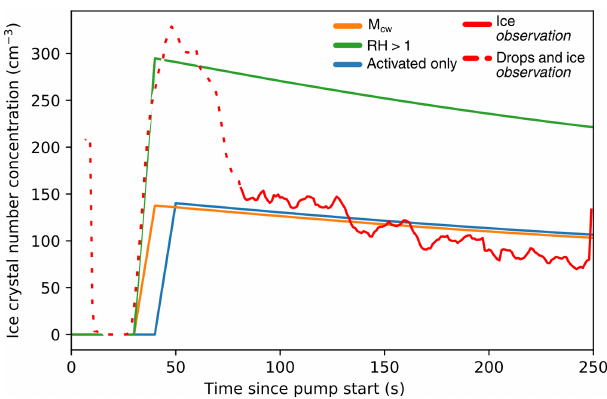
Figure 2. Number concentration of ice crystals in a chamber exper- iment and model simulations using different criteria for freezing. The solid red line is the number concentration of ice measured in the chamber, the dashed red line represents the sum of liquid droplets and ice crystals initially formed and the other coloured lines are sim- ulated ice number concentrations using different criteria for freez- ing in the model.